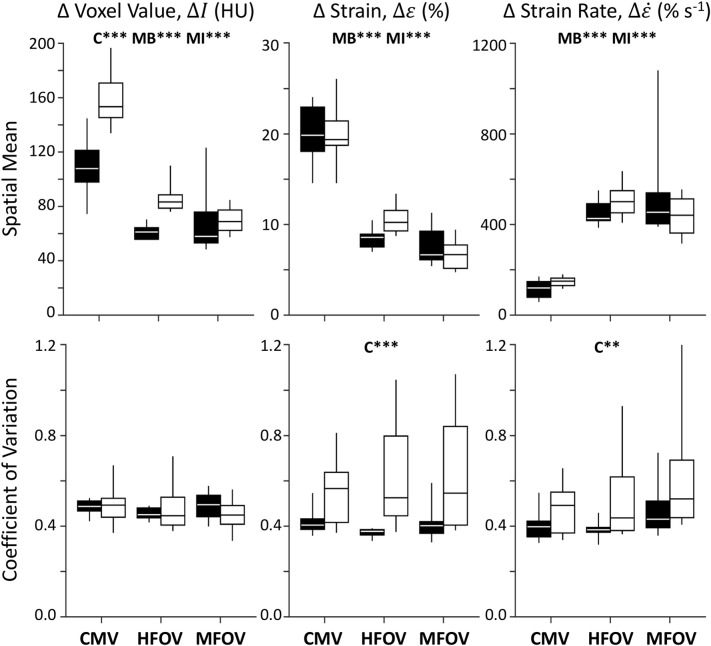
Summary of image registration-based regional ventilation measures for intratidal changes in aeration (ΔI), volumetric strain (Δε), and volumetric strain rate (Δε˙). Mean and coefficient of variation throughout the lung mask are shown for each variable, represented by box plots showing minimum, maximum, and quartiles across subjects under baseline (black) and injured (white) conditions, during conventional mechanical ventilation (CMV), high-frequency oscillatory ventilation (HFOV), and multi-frequency oscillatory ventilation (MFOV). Asterisks indicate significance levels (**p < 0.01, ***p < 0.001) for main effects (C = lung condition, MB = modality for baseline condition, MI = modality for injured condition). See Table 2 for additional clarification.